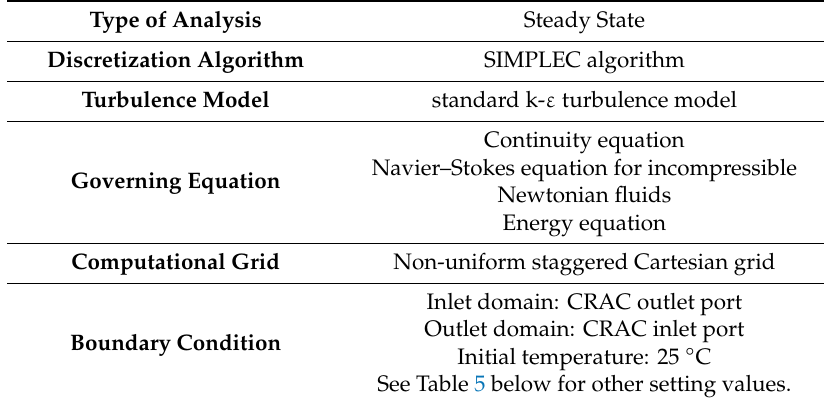
Table 4. Simulation set-up.